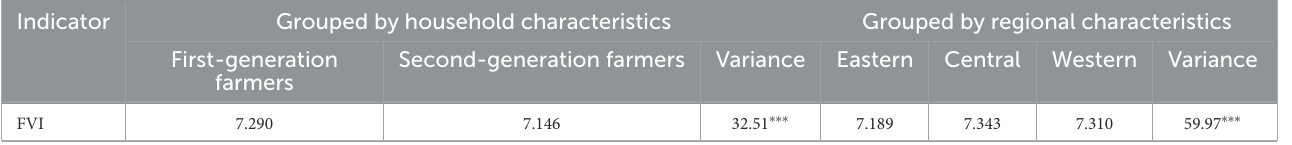
TABLE 8 Levels of financial vulnerability of farm households with different household characteristics and regional characteristics. Indicator